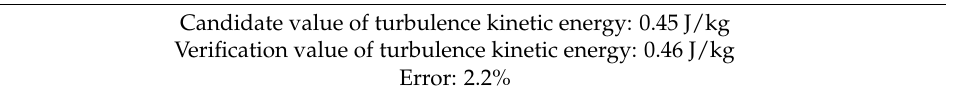
range of design parameters.